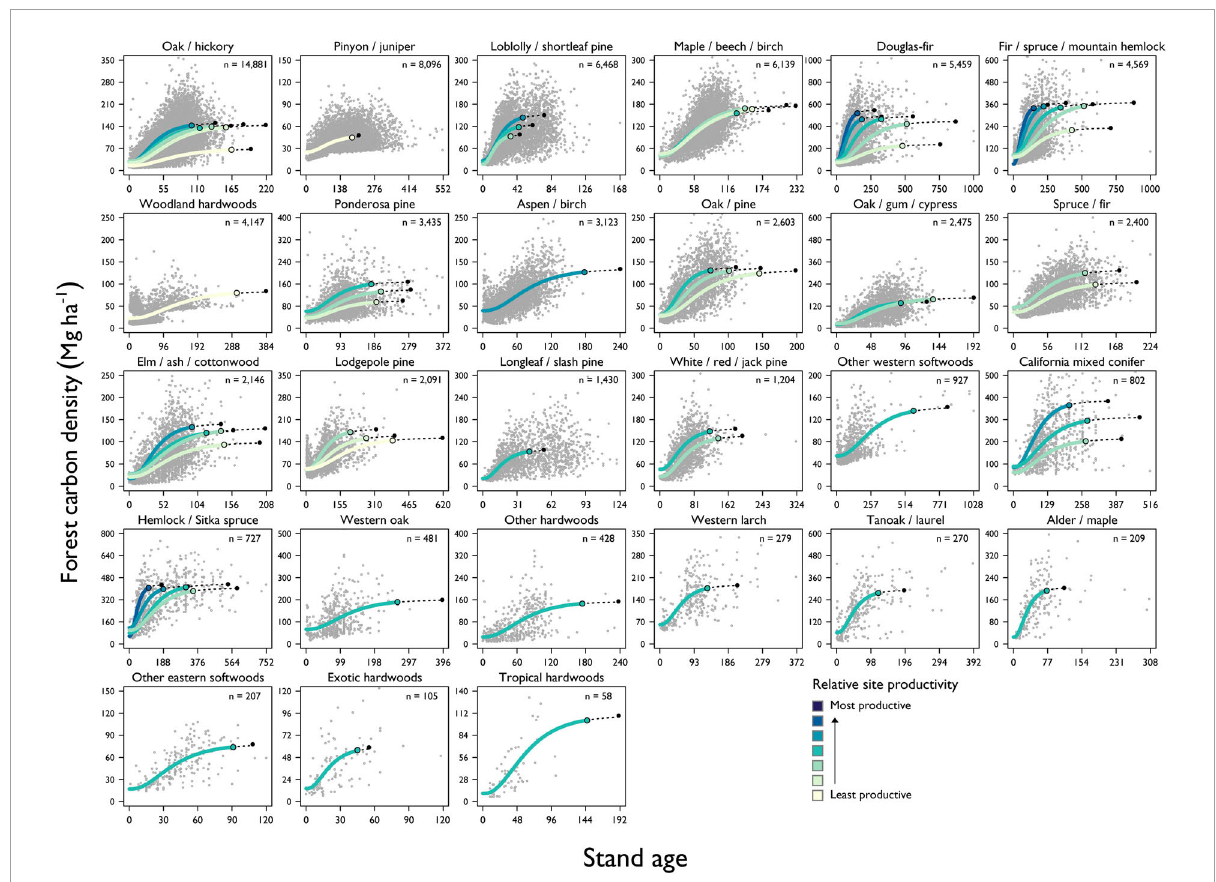
FIGURE3 Model results of forest carbon accumulation for forest type-groups in the United States. When feasible, multiple forest carbon accumulation curves along a gradient of site productivity were fit to the forest inventory data. Each point in the scatter plot represents a unique FIA plot and the total number of plots within each forest type-group used in model fitting is presented in the panel’s upper right. The point at which the forest carbon accumulation curves reach 95% of the modeled asymptotic level is represented by the colored, filled circles. This point is used to derive the age at the onset of old-growth forest characteristics. The forest carbon accumulation curves are extended with dashed lines from the age at the onset of old growth to the modeled asymptotic level of forest carbon